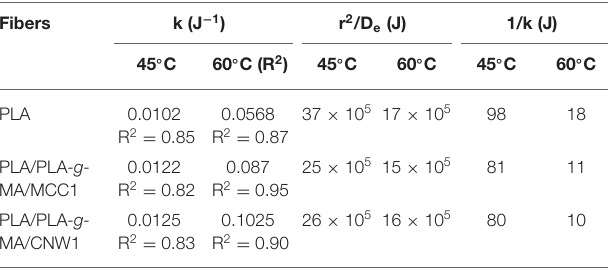
TABLE 2 | Hydrolysis parameters (hydrolysis rate constant k, coefficient of correlation R 2 , timescale for diffusion and timescale of reaction) of PLA, PLA/PLA -g- MA/MCC1, and PLA/PLA -g- MA/CNW1 fibers at 45 and 60 ◦ C in hygrothermal conditions.